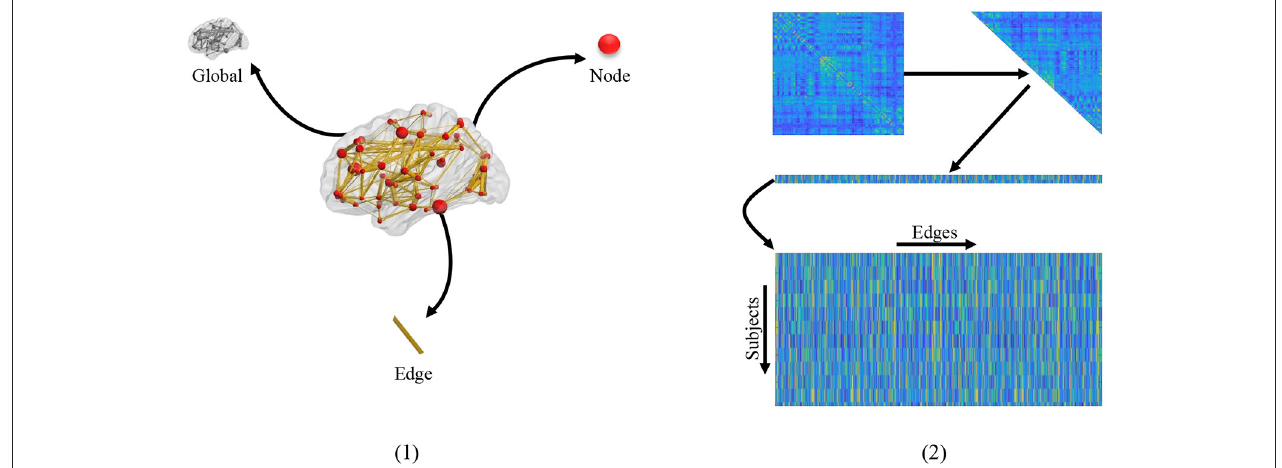
FIGURE 1 | (1) Different granularity of feature. From the clockwise direction is the global-level topology feature, node-level topology feature, and edge-level topology feature, respectively. (2) The mechanism of traditional edge feature extraction in FBN. The network adjacency matrix from each subject is first mapped onto a vector by removing the redundant part if the matrix is symmetric, and then the vectors from all subjects are rearranged together as an input of the following feature selection